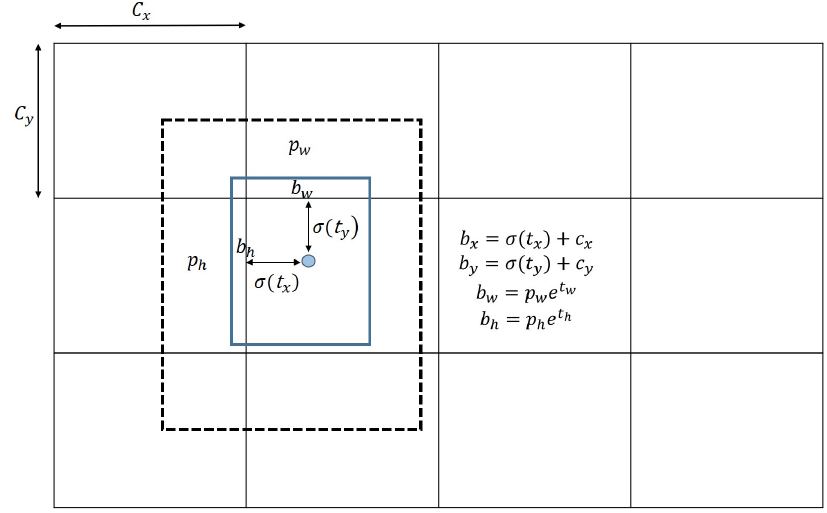
Figure 1. Bounding boxes with dimension priors and location